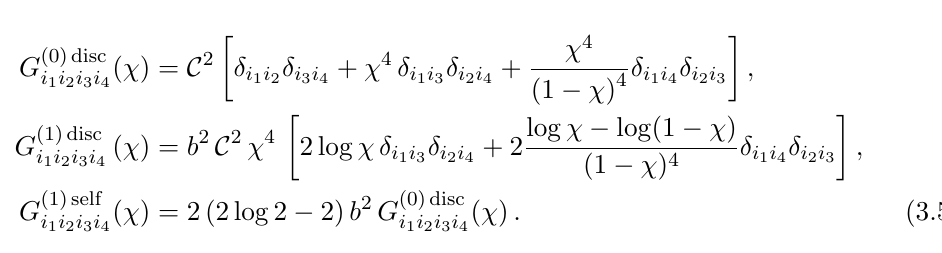
Figure 1 . Connected diagrams of order O ( b 2 ) contributing to ⟪ (cid:8) i In